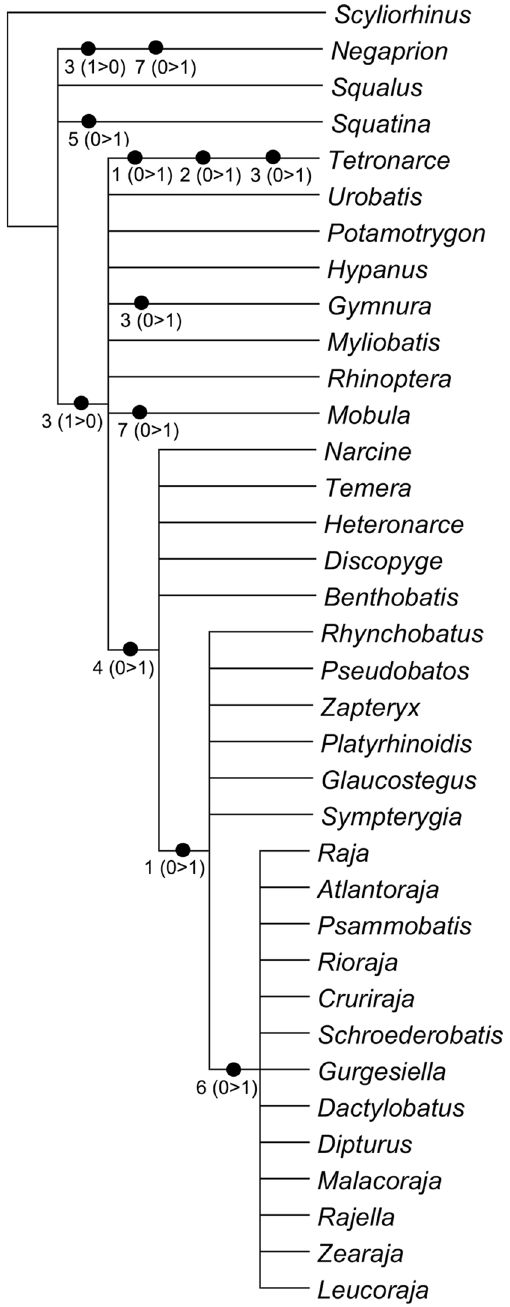
Figure 9. Strict consensus of the five equally most-parsimonious cladograms of 14 steps (CI = 0.71; RI = 0.91) resulted from the analysis including only characters from the afferent branchial arteries and character states